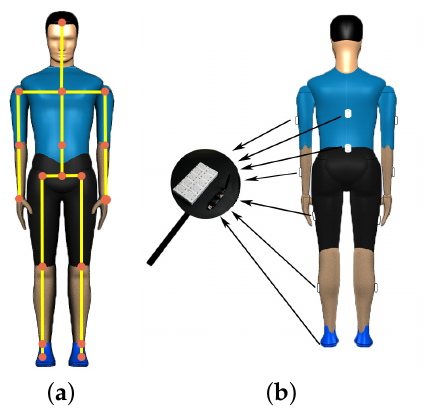
Figure 3. The human rigid structure model and the device locations. ( a ) the whole body structure definition with rigid body model. ( b ) postions of sensor nodes during the experiment.